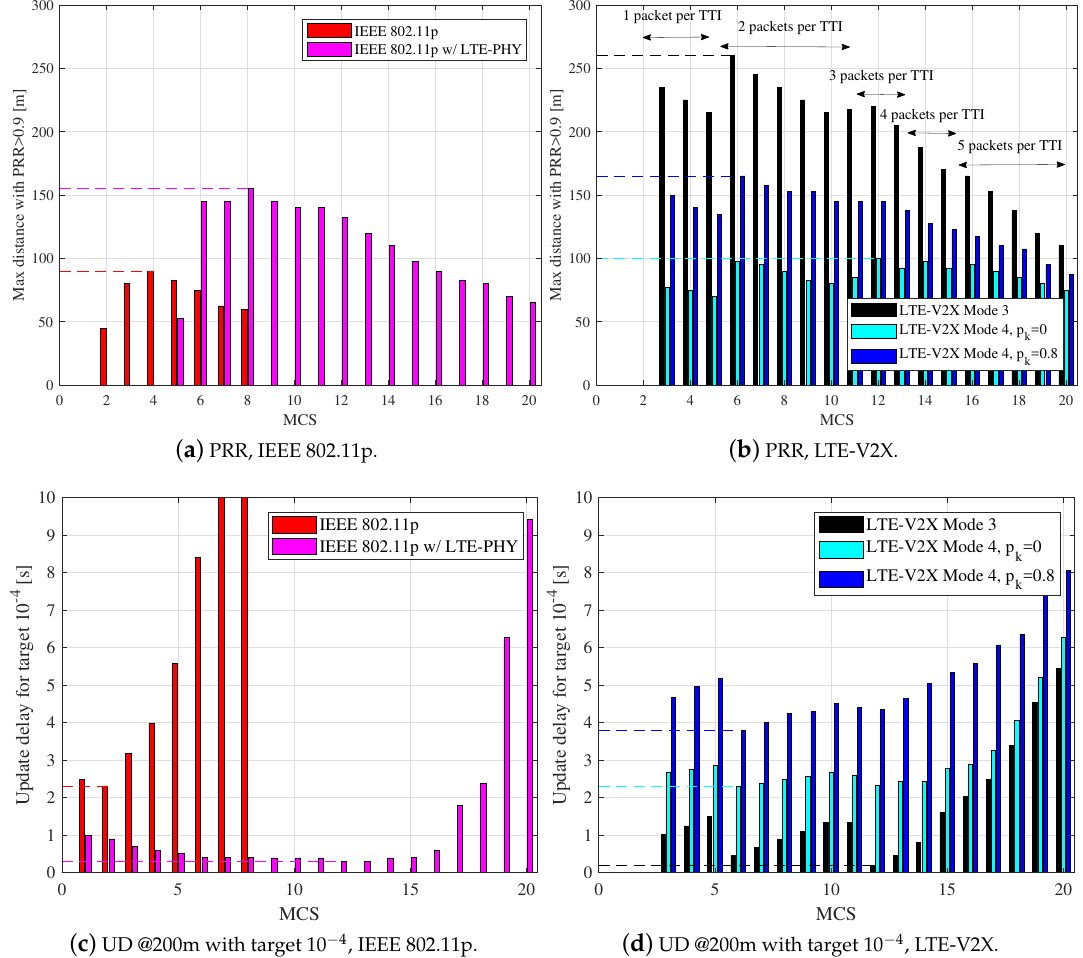
Figure 3. Packet reception ratio and update delay in